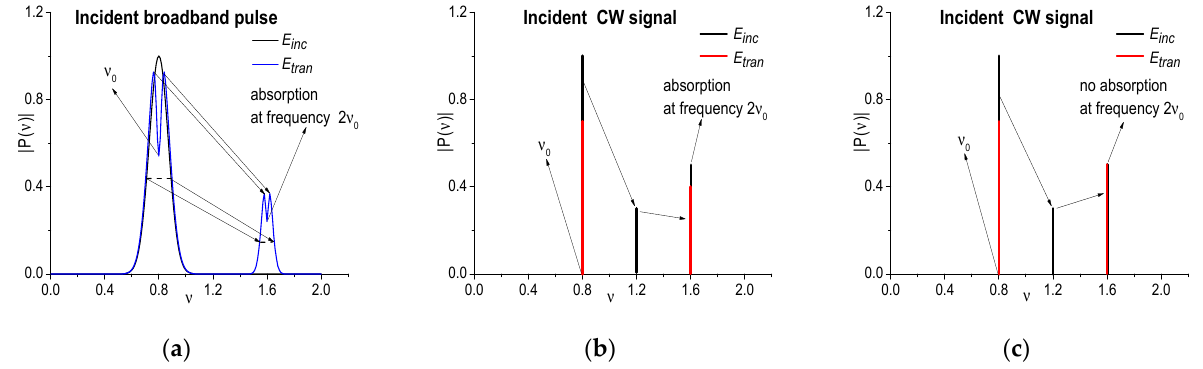
Figure 1. Scheme of verification of the substance absorption frequencies observed under the action of the incident broadband THz pulse. The black line in ( a ) denotes the spectrum of the incident broadband THz pulse ( E inc ) and the blue line denotes the spectrum of the pulse ( E tran ) transmitted through the substance: two spectral lines near the frequencies ν 0 (basic absorption frequency) and 2 ν 0 (doubled absorption frequency). The black lines in ( b , c ) denote the spectrum of the incident THz CW radiation ( E inc ) with scanned carrier frequency, and the red lines denote the spectrum of the THz CW radiation ( E tran ) transmitted through the substance. In ( b ) the absorption at the frequency 2 ν 0 is present, and in ( c ) it is absent. The modulus of the spectral amplitude is denoted as | P ( ν ) |